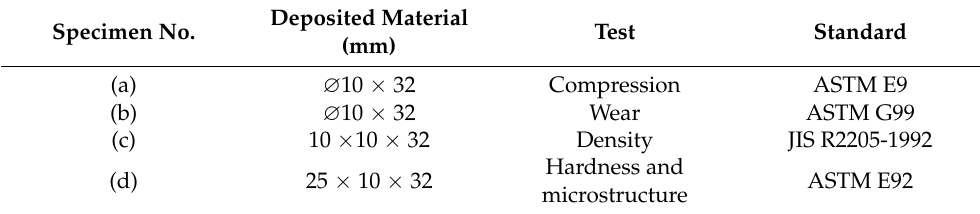
Table 2. Dimensions and standards of the cut specimens for different tests. Specimen